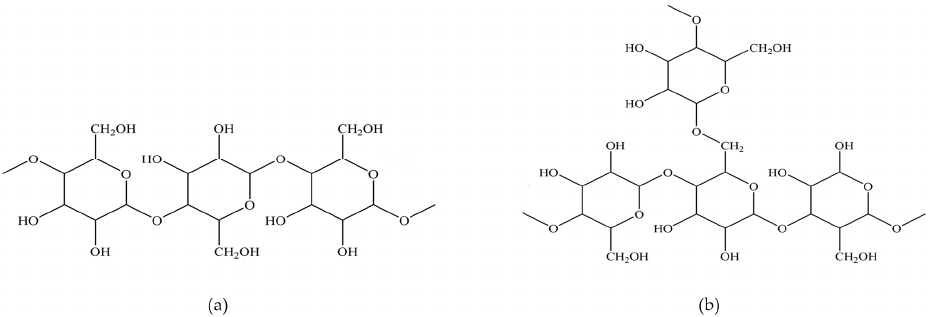
Figure 3. The chemical structure of Amylose and Amylopectin. ( a ) Amylose; ( b ) Amylopectin